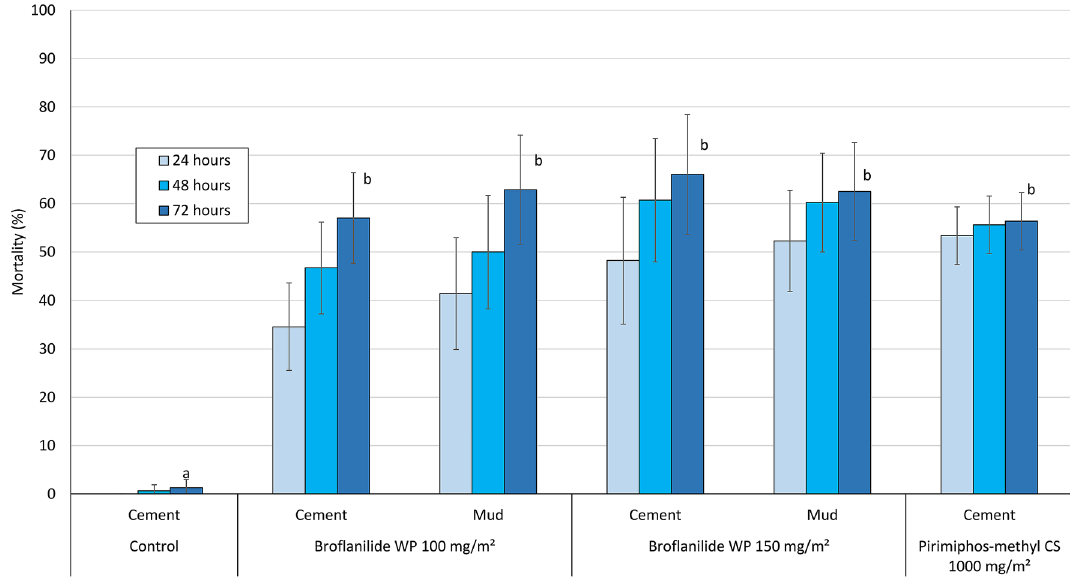
Figure 5. Overall mortality of wild free-flying pyrethroid-resistant An. gambiae sl at 24, 48 and 72 h after collection from experimental huts in Covè, Benin. Bars bearing the same letter label are not significantly different at the 5% level (logistic regression). Error bars represent 95% confidence intervals. Broflanilide WP induced a delayed mortality effect on wild vector mosquitoes in experimental